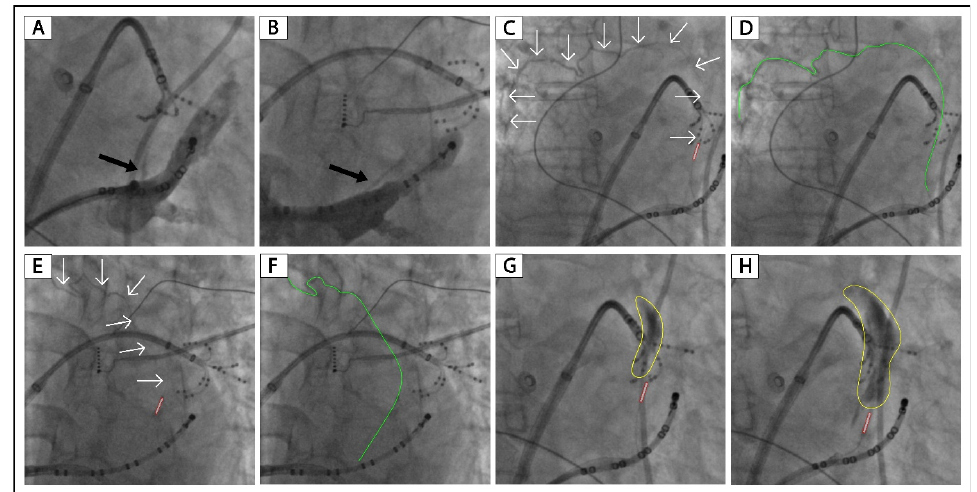
Figure 3. Successful ethanol infusion in a VOM with collateral circulation to the right superior vena cava. ( A , B ): Non ‐ occluded venograms of VOM in the RAO and LAO projection, respectively. C and E: Balloon occluded venograms of VOM in the RAO and LAO projection, respectively. ( D , F ): High ‐ lighted VOM of panels ( C , E ). ( G , H ): Balloon occluded venograms of VOM in the RAO projection after 4 and 8 mL of ethanol infusion, respectively. The black arrow indicates the ostium of VOM. The white arrows and green lines indicate the drainage of the VOM. The tubule outlined in red indicates the angioplasty balloon. The yellow circles indicate localized myocardium staining. VOM, the vein of Marshall; RAO, right anterior oblique; LAO, left anterior oblique.